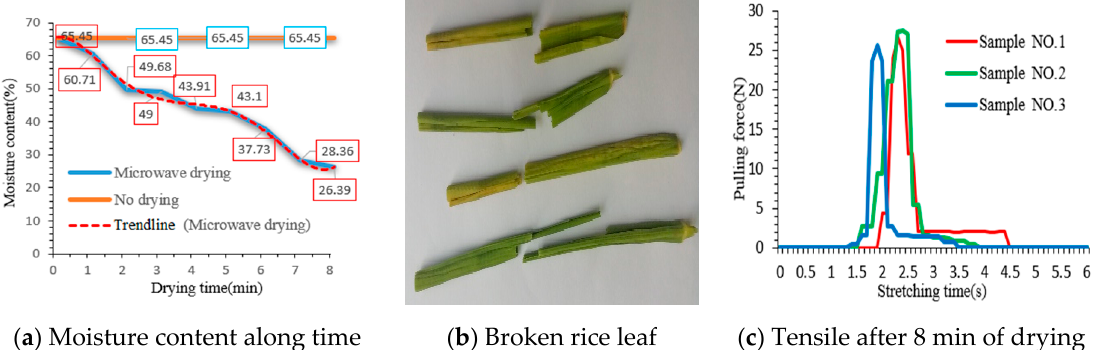
Figure 8. Effect of microwave drying time on moisture content. Figure 8. E ff ect of microwave drying time on moisture content.